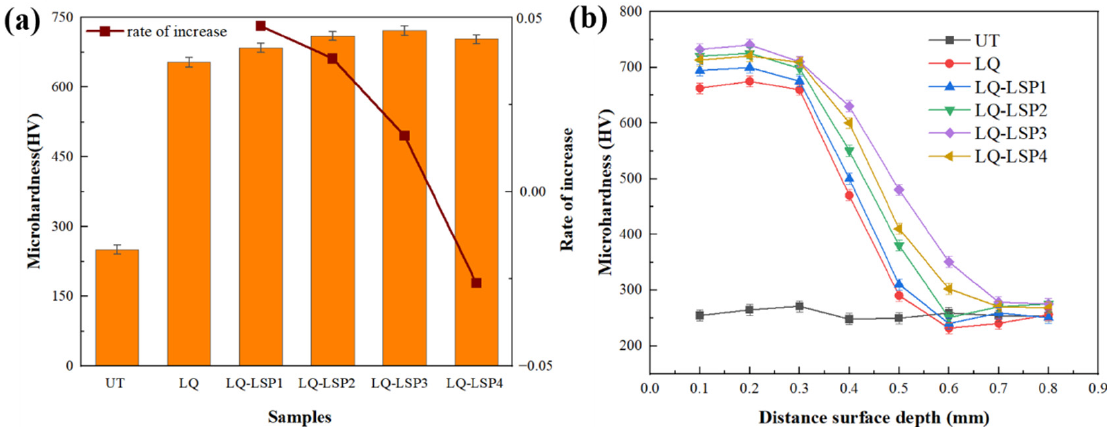
Figure 8. The surface microhardness and cross-sectional hardness distribution of samples treated with different processes—( a ) surface microhardness; ( b ) cross-sectional hardness .